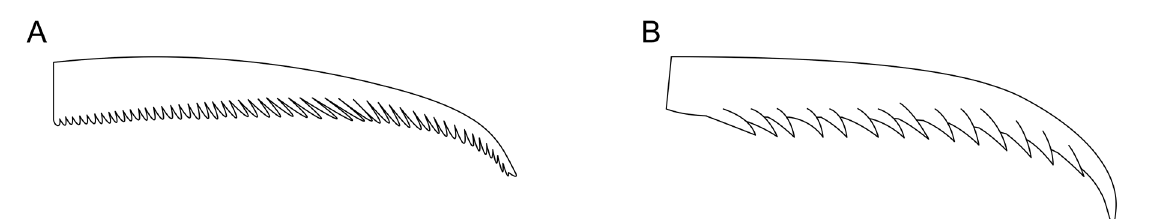
Fig. 99. Middle tibial spurs. A . Minutely serrate. B . Finely pectinate.